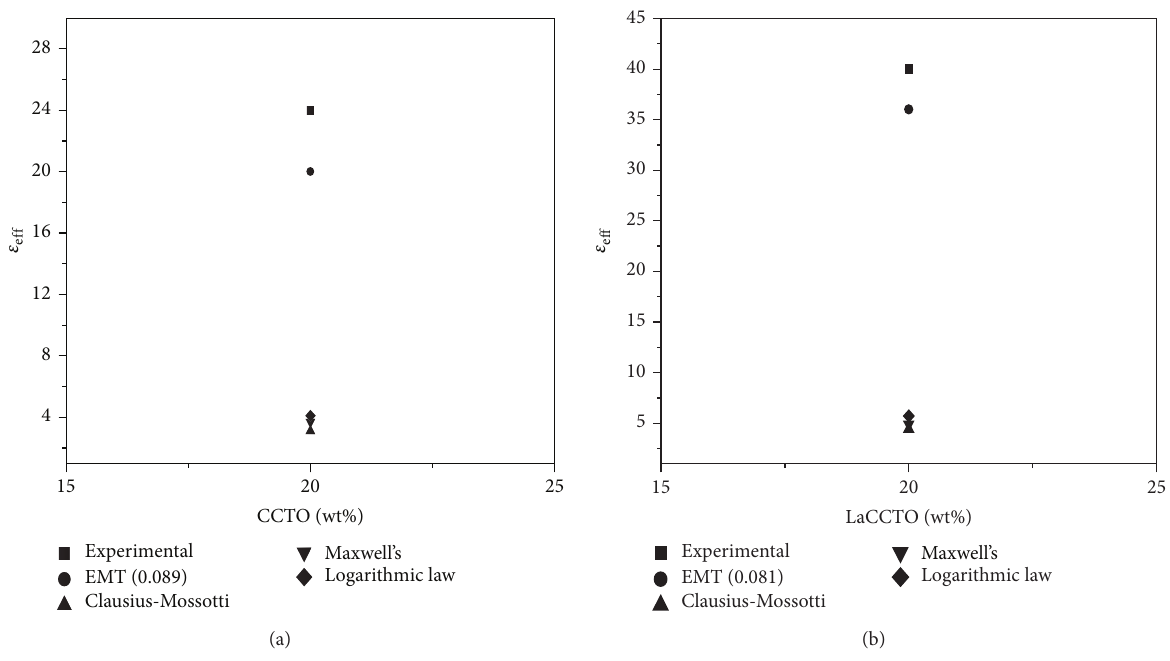
) measured at 100 Hz and 40 ∘ C for PVDF-20C and PVDF-20LaC composites based on eff